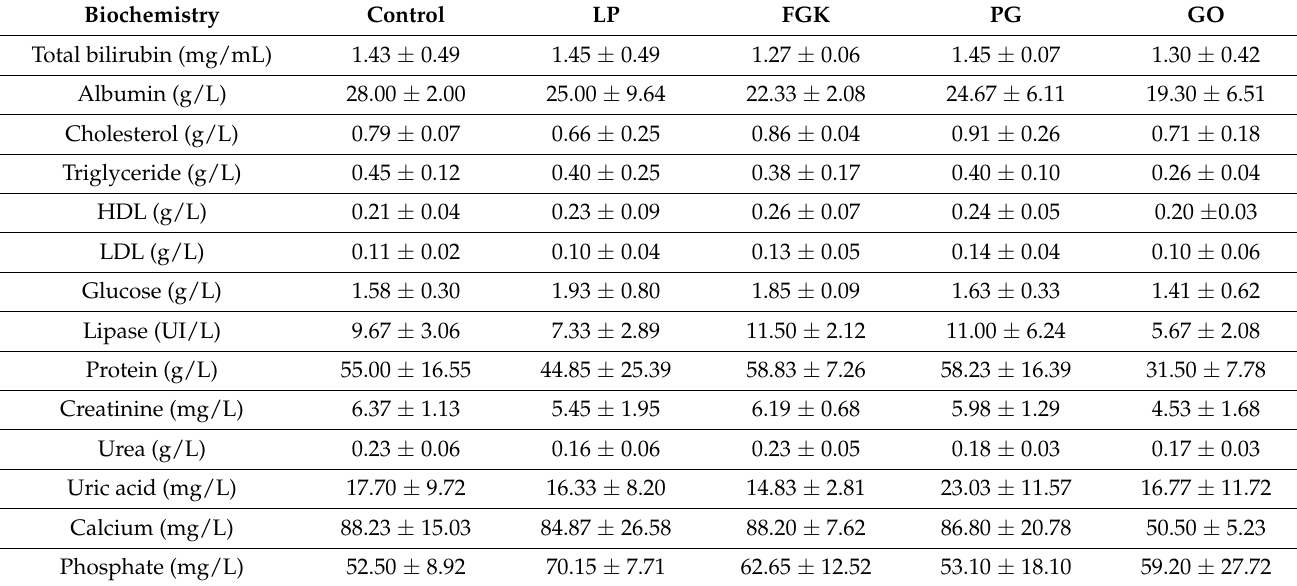
Figure 9. Histological analysis of tissues from control or Lavandula pedunculata (LP) treated rats. Rats were given LP or water every day for 4 weeks by gavage. Liver, spleen, and kidney slices were analyzed from control ( a , c , e , respectively) or LP-treated rats ( b , d , f , respectively). No cellular mod- ifications were observed in the rats receiving LP in comparison with the control.